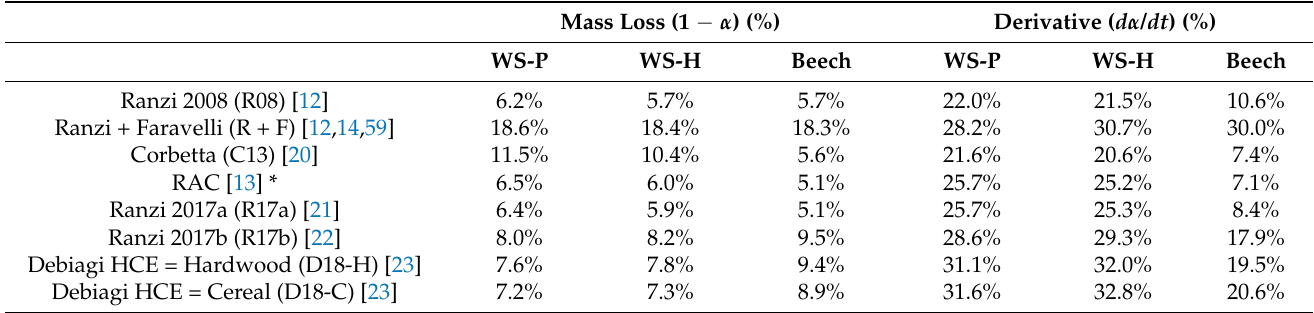
Table 12. Root sum of square errors between the (1 − α )/ d α / dt curves and the summative fits of curves based on literature-found reaction network kinetic values.